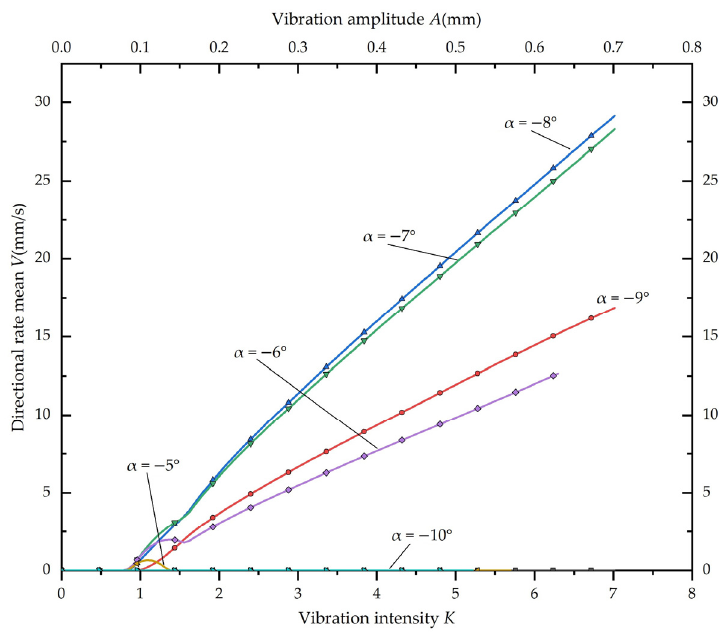
Figure 8. The surface of the trough is PU belt.